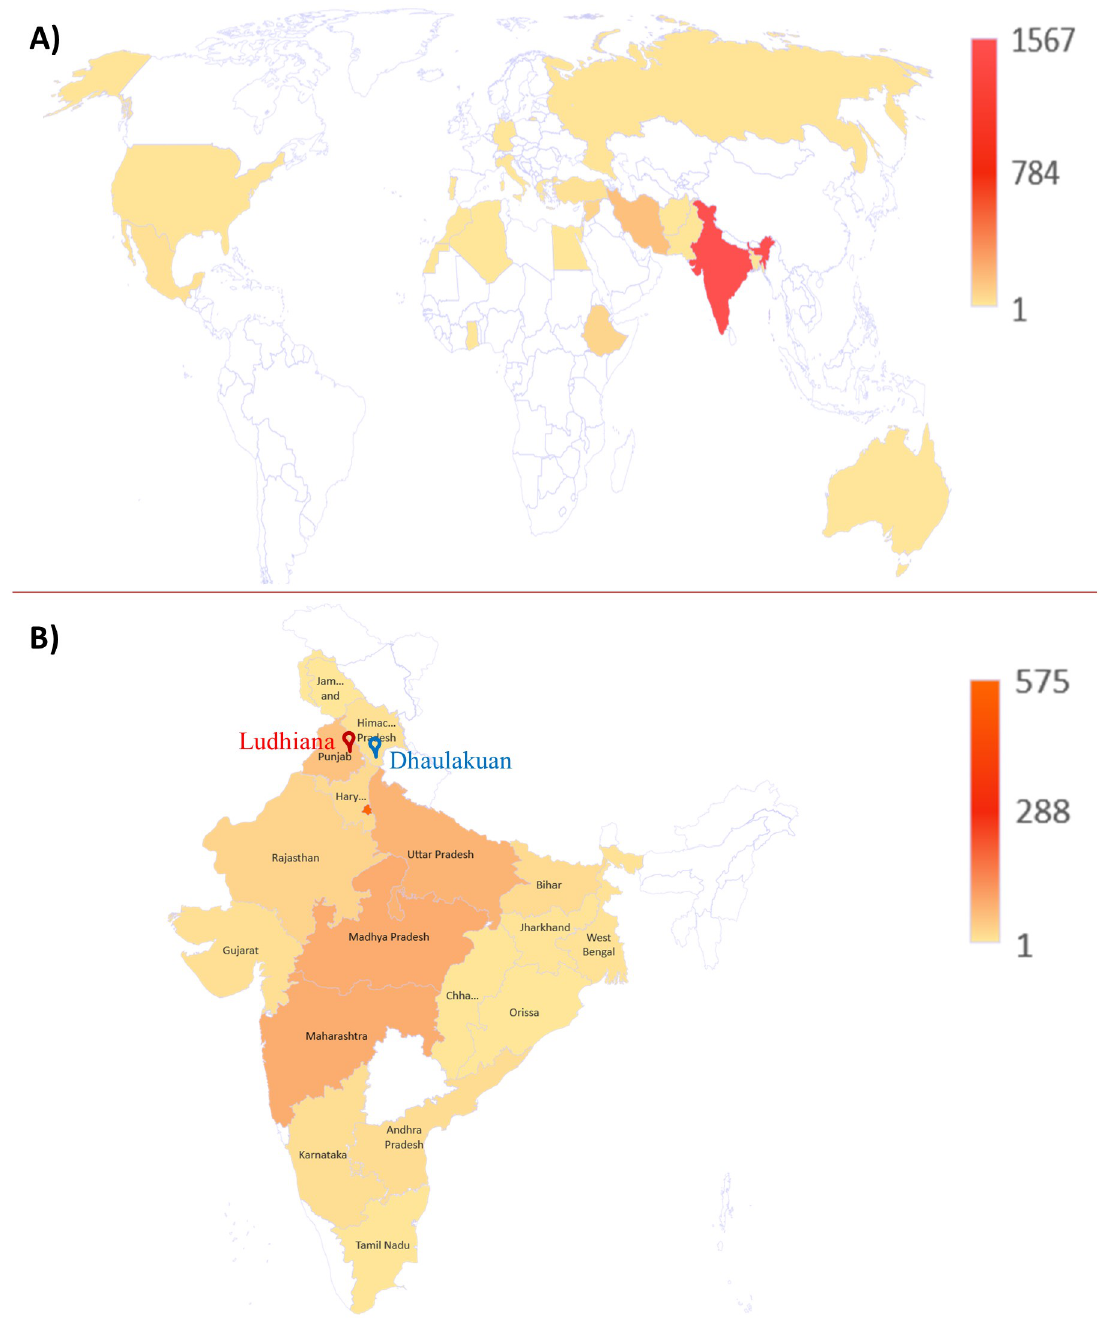
Fig 1. Representation of chickpea germplasm from 17 countries in world map (A) and 18 states (B) in Indian map. Colour intensity represents the number of accessions from the geographical location. Blue and red highlighted marks are the experimental locations in